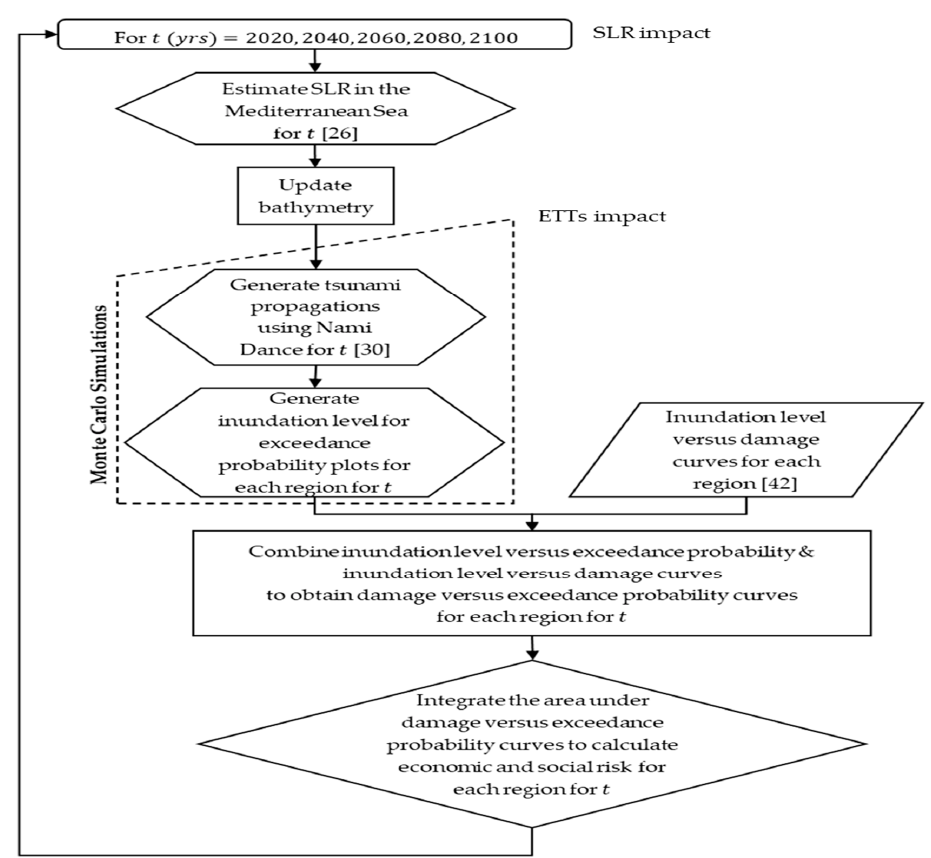
Figure 2. Flowchart of the methodology.